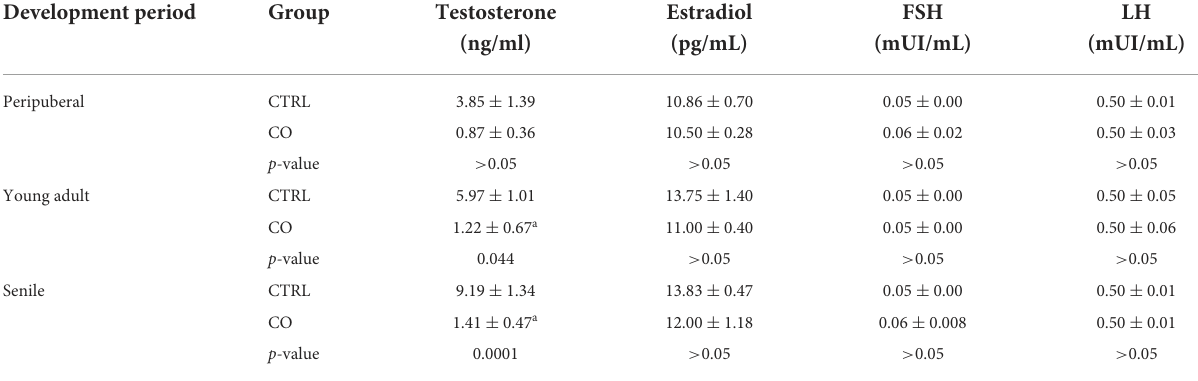
TABLE 2 Hormone concentrations in the control and cryptorchid groups at different developmental stages in the dog. Development